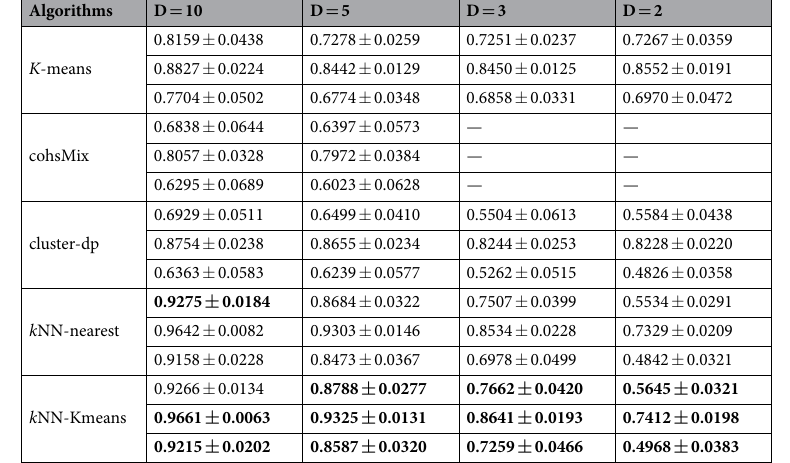
Table 4. Results on LFR networks with numerical attributes, μ = 0.7.